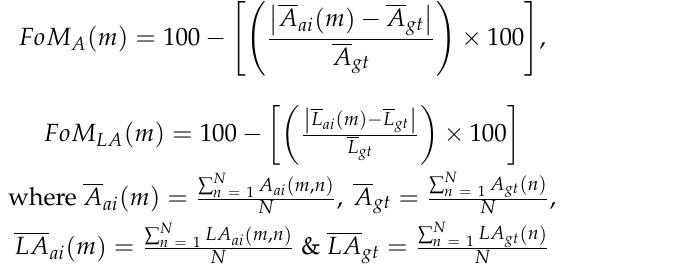
Figure of Merit The likelihood of the error in the system is known as the figure of merit (FoM). We have calculated FoM for (i) lung area and (ii) lung long axis to show the acceptability of the hypothesis if the % difference between the two observers is <5%. Table 4 shows the values for FoM using Equation (5) and the % difference for the three AI models against the two observers. Similarly, Table 5 shows the values for FoM using Equation (6) and the % difference for the three AI models against the two observers.